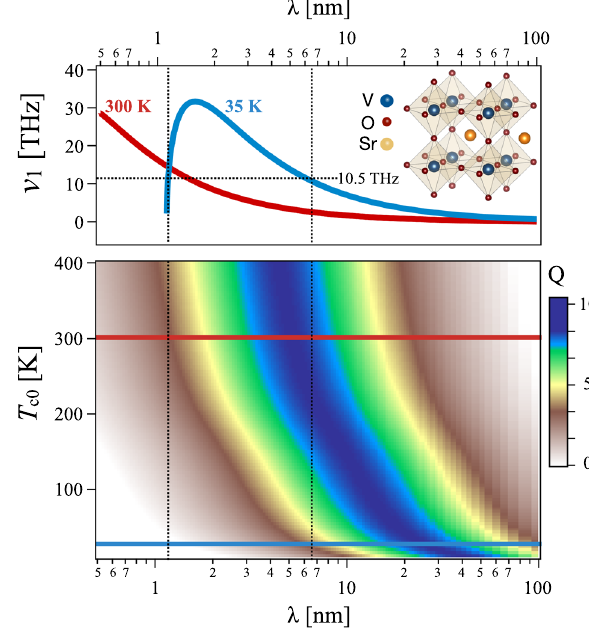
Fig. 6 Temperature wave dispersion in SVO 3 . Top panel: electronic temperature oscillation frequency vs oscillation ’ s wavelength, λ , at a base temperatures T c 0 = 35 K (blue line) and 300 K (red line). Inset: Structure of SVO 3 . Bottom panel: quality factor (colormap) as a function of the oscillation ’ s wavelength, λ , and the base temperature T c 0 . Calculations are based on the dispersion relations, Supplementary Eqs. (1) – (3), upon insertion of input parameters from experiments, α and τ T , and from non- equilibrium thermal dynamics results from the layered Hubbard model (see text), τ q . In both panels a linear-log plot is